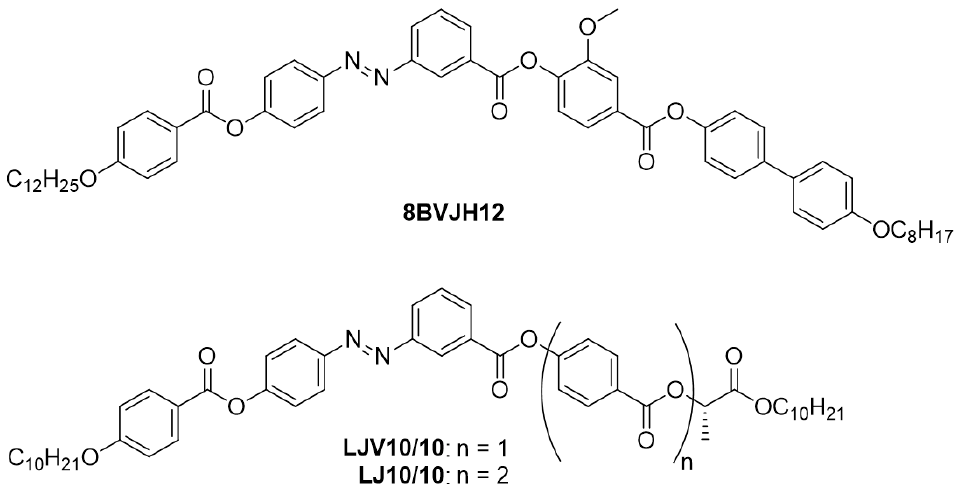
Figure 1. Chemical formulae of the studied compounds 8BVJH12 , LJ10/10 and